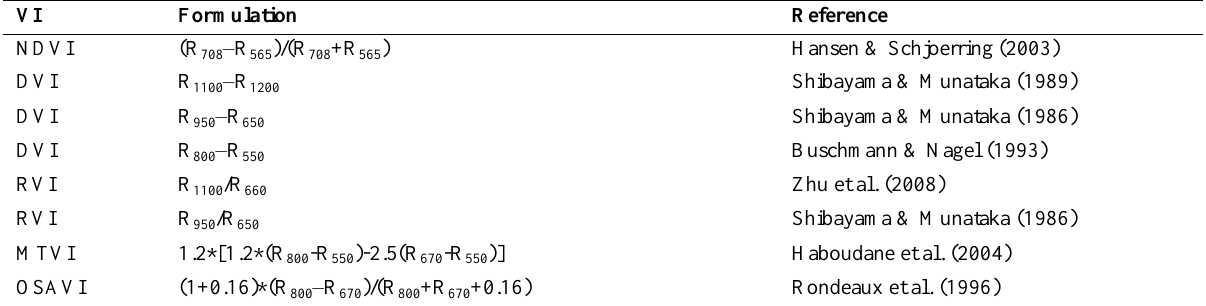
Table 1. Standard VIs evaluated in this